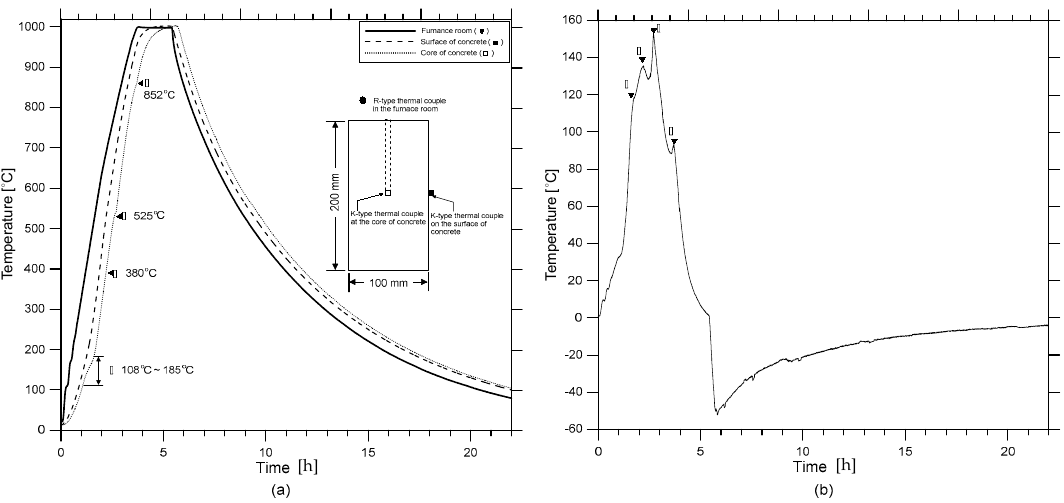
Figure 2. Temperature development and thermal gradient inside concrete exposed to maximum temperature of 1000 °C: ( a ) temperature development, and ( b ) thermal gradient between the surface and core of a concrete cylinder.